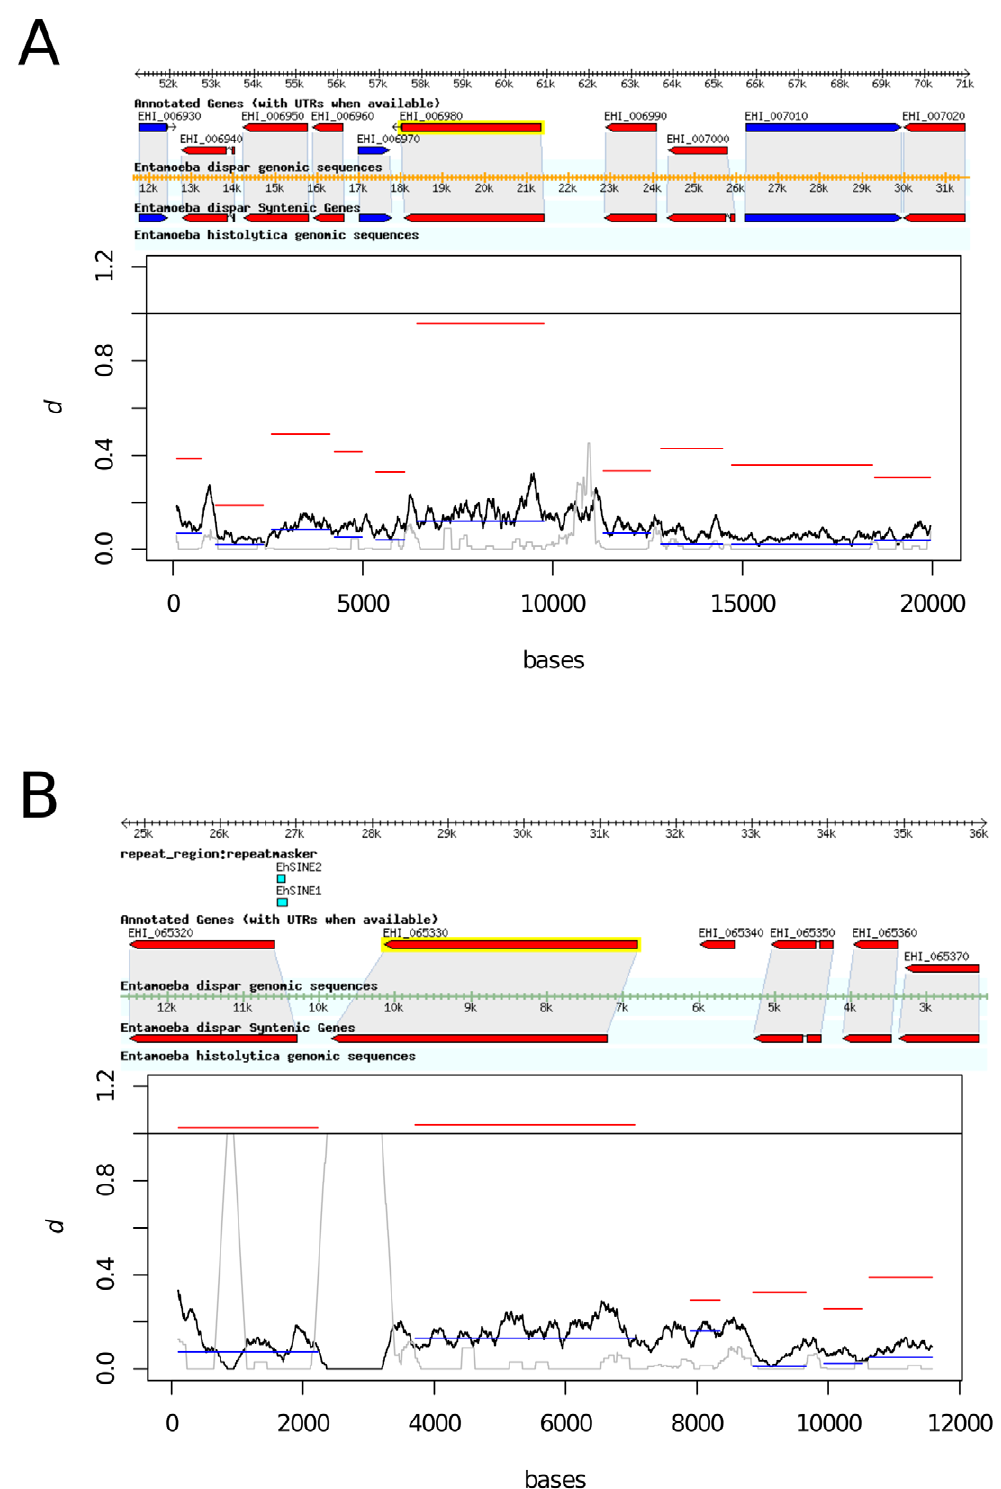
Figure 1. Divergence across chromosomal regions genes of E.histolytica and E.dispar containing intermediate-chain lecin genes. (A) igl1 (EHI_006980:EDI_276450); (B) igl2 (EHI_065330:EDI_244250). Divergence ( d ) for a 200 bp sliding window is shown (black line), and dN (blue bars) and dS (red bars) are plotted for putative coding regions. The grey line shows the proportion of gapped positions in each window, an indication of poor alignment quality. Both lectin genes show dS values near to 1, notably higher than for surrounding genes, except gene EHI_065320 which also shows dS . 1.